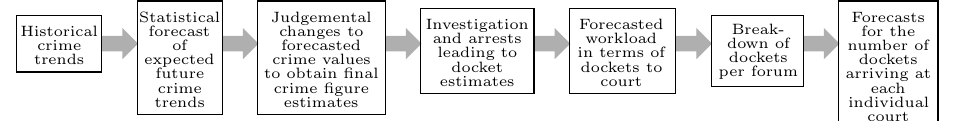
A schematic representation of the process of modelling NPA workload (dockets received at court).